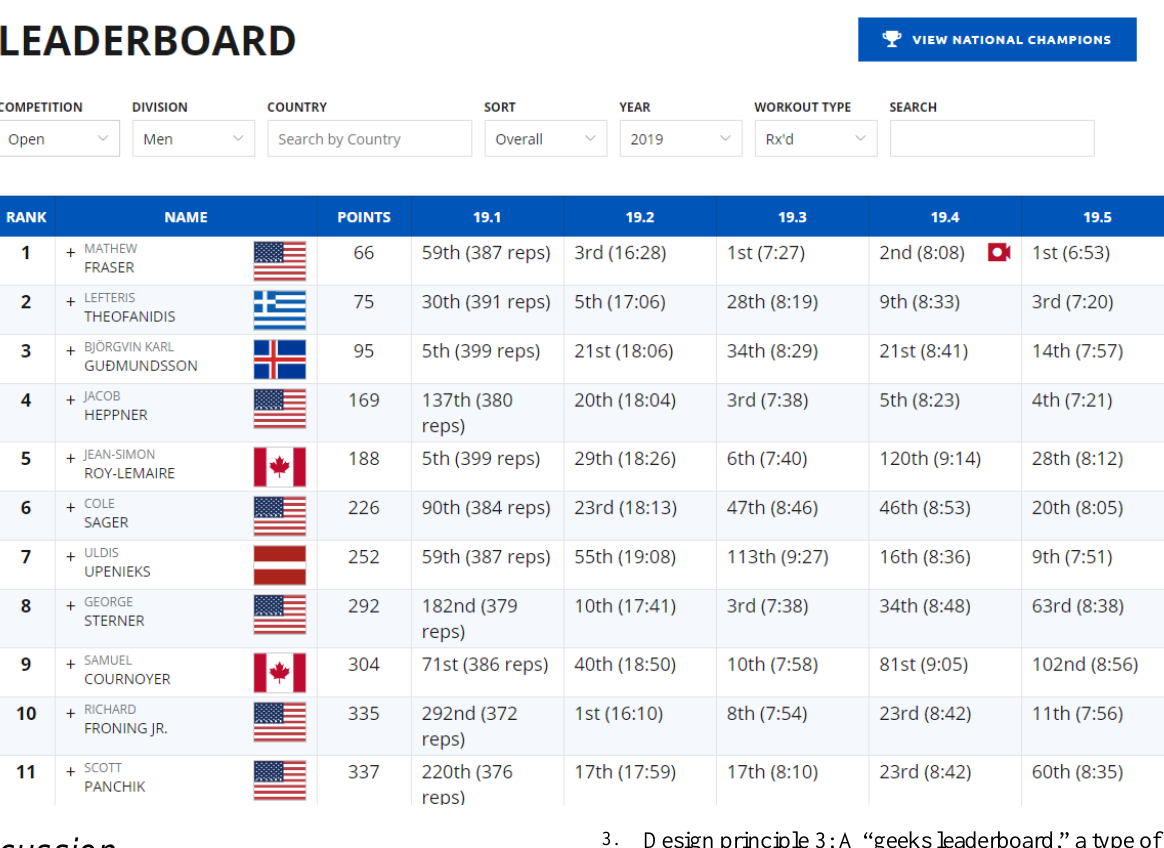
Figure 8. Leaderboard used in Reebok Crossfit’s “The Open”